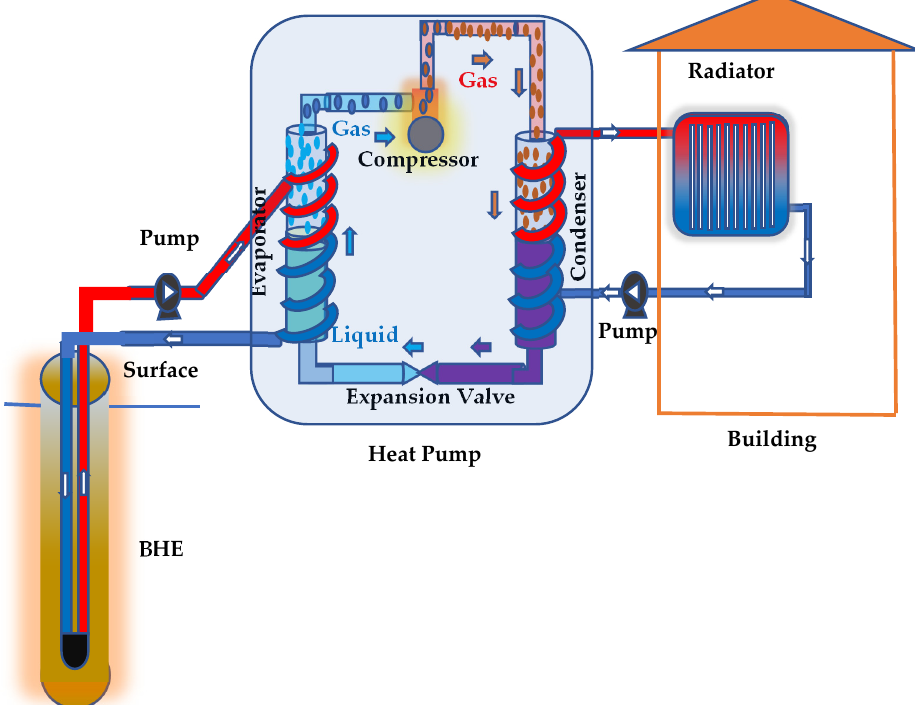
Figure 2. Schematic flow diagram of GSHP systems for heating model (cooling mode with reversed flow).